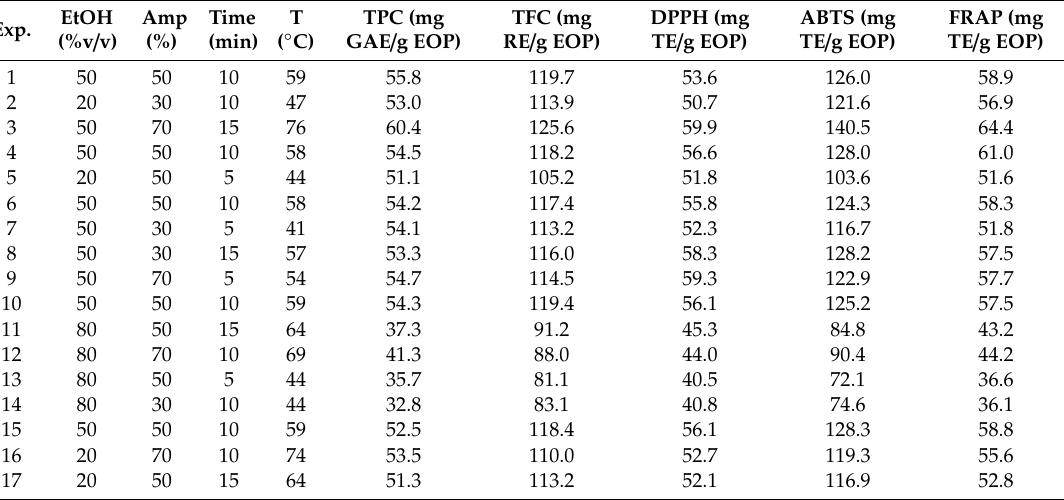
Table 2. Experimental conditions for ultrasound-assisted extraction (UAE) for extracted olive pomace (EOP) and experimental data for the responses.